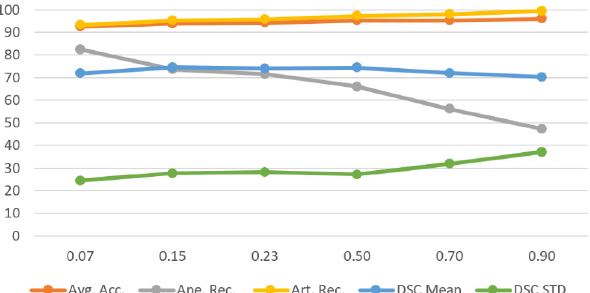
Fig. 11 Comparison with different discrimination thresholds for Fold 0 (due to the random sampling of the input points, the results may fluctuate slightly each time).